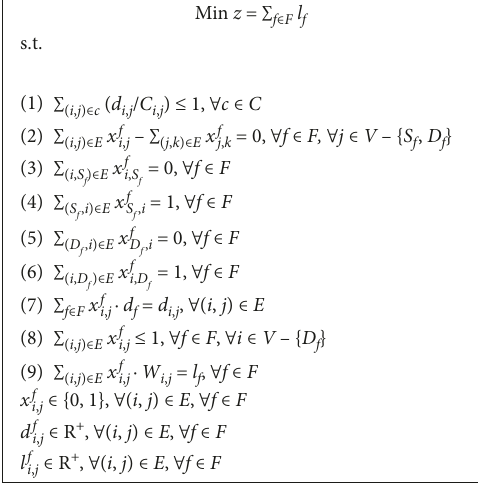
Figure 2: Shortest path routing algorithm using integer linear programming formulation.